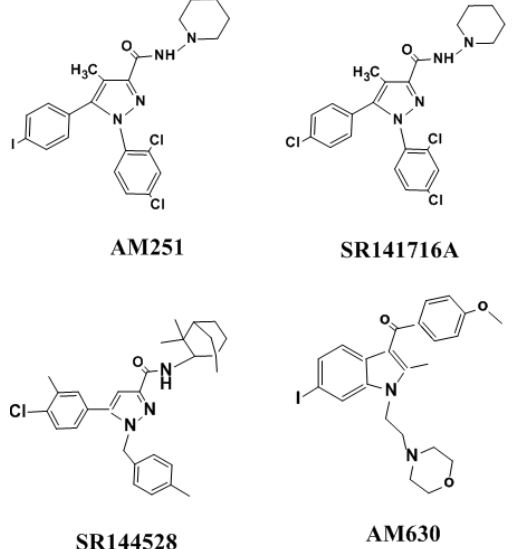
Figure 3. The structure of selective CB1R and CB2R antagonists.